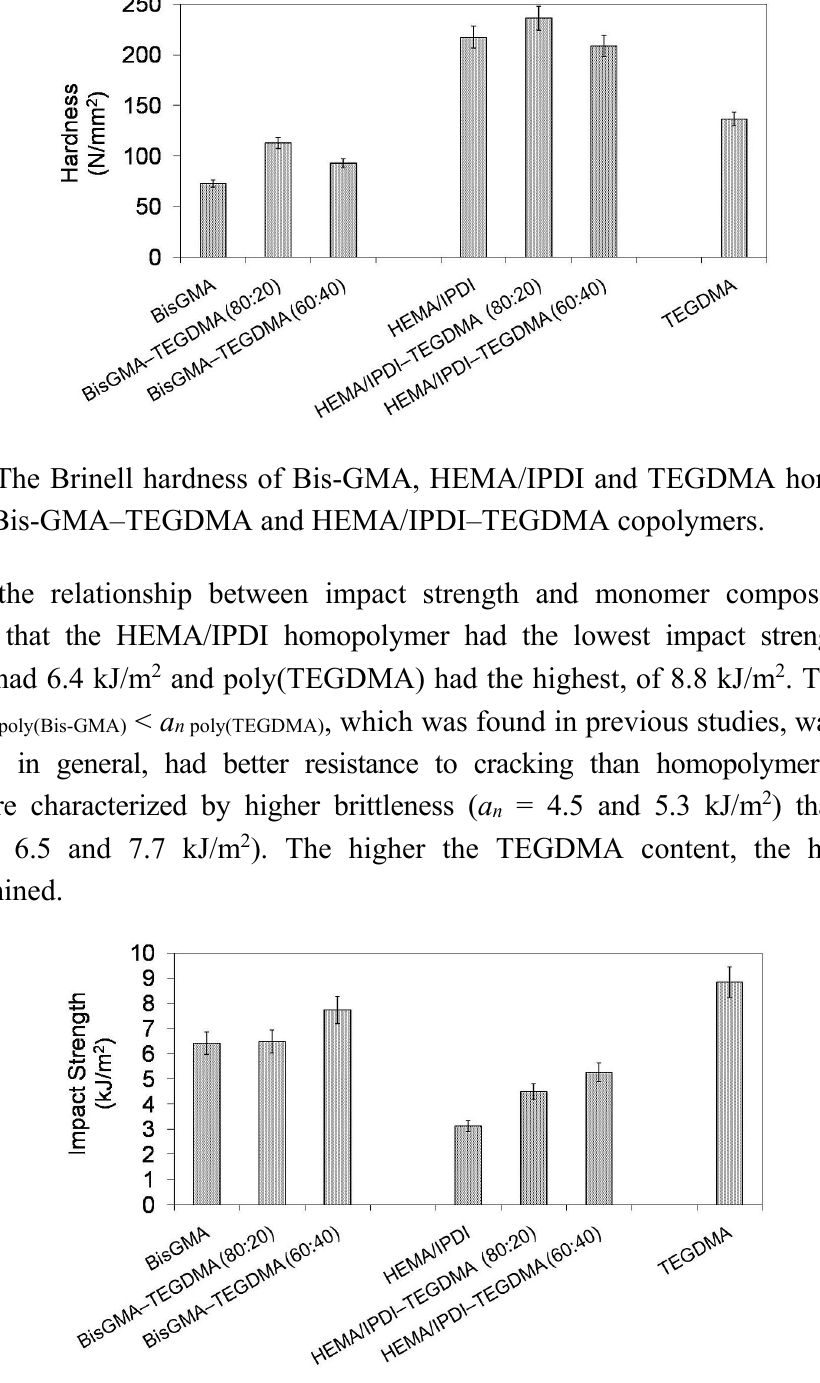
Figure 5. The impact resistance of Bis-GMA, HEMA/IPDI and TEGDMA